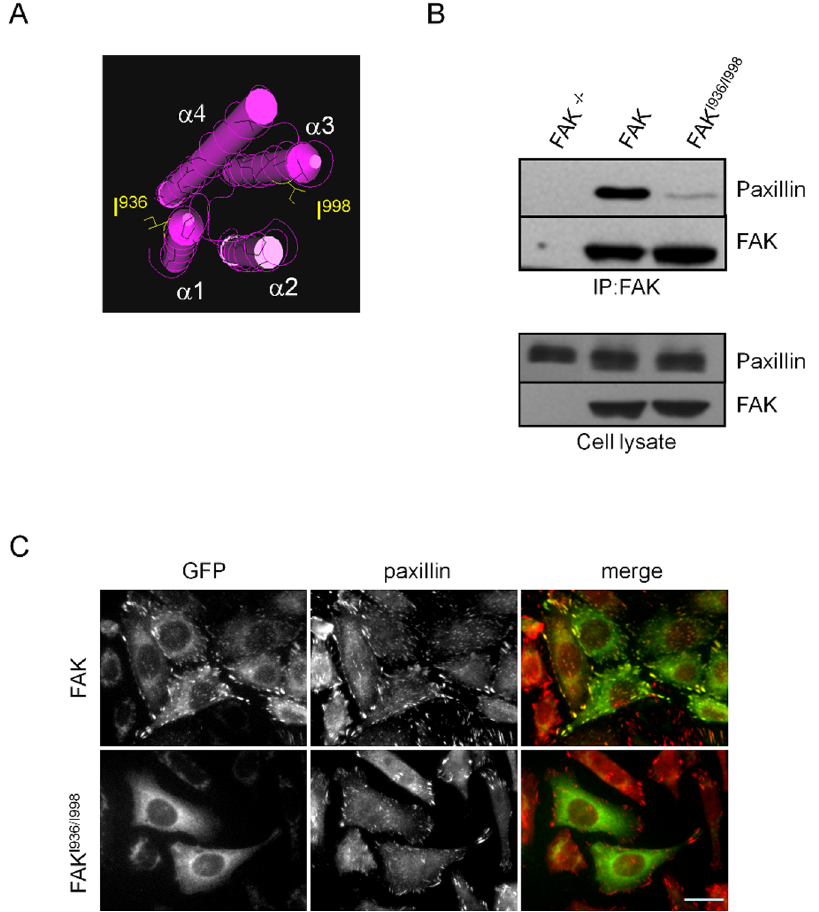
Figure 1. Analysis of FAK-paxillin interaction in wild-type FAK and FAK I936/I998 cells. (A) Structural view of the 4 helix bundle ( a 1- a 4) of the FAT domain. Paxillin binds to 2 hydrophobic patches located at the interface of a -helix 1/4 and the interface of a -helix 2/3. The I936E and I998E mutations are indicated. (B) Representative blots showing wild-type FAK and FAK I936/I998 immunoprecipitated using anti-FAK Ab and blotted for paxillin and FAK. The expression level of proteins in the corresponding cell lysate is shown. (C) Confocal images from fixed cells expressing wild-type or mutant FAK (fused to GFP) and immunostained for a marker of FAs, paxillin (red). Note the absence of FAK at FAs in mutant cells. Scale bar, 20 m m.